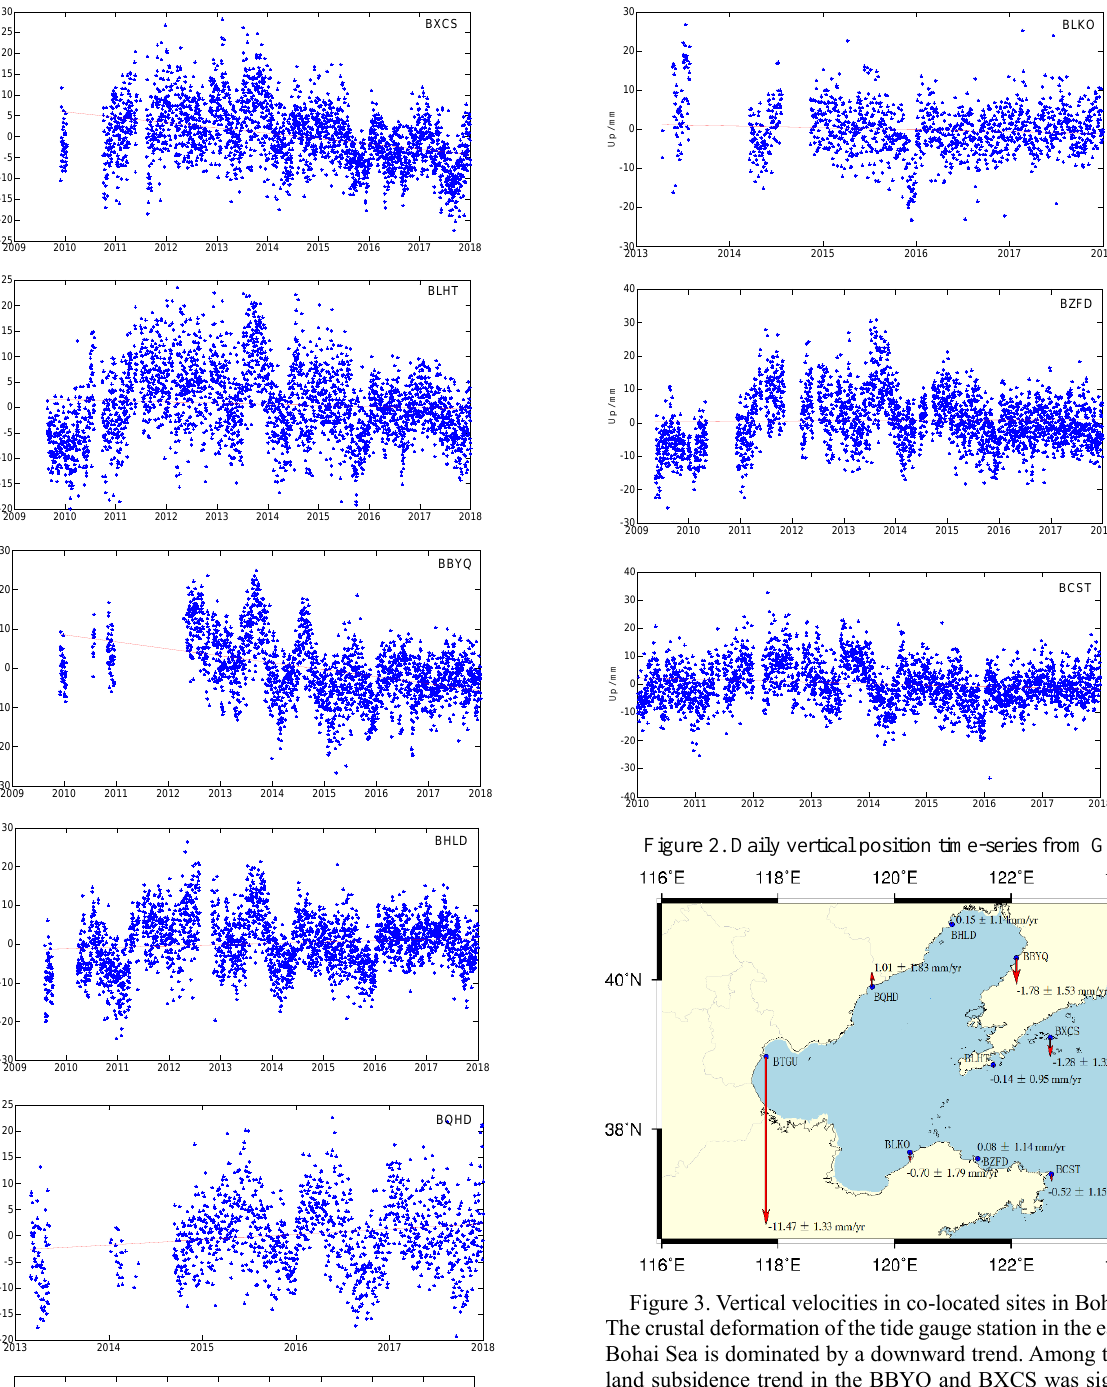
Figure 3. Vertical velocities in co-located sites in Bohai sea The crustal deformation of the tide gauge station in the east of the Bohai Sea is dominated by a downward trend. Among them, the land subsidence trend in the BBYQ and BXCS was significant, with an average annual settlement of more than 1mm. The land subsidence trend in the BLHT tide gauge is gentle, and the annual average settlement is about 0.14 mm. The vertical land motion of tide gauges in this area has a gradually decreased trend from north to south. The vertical land motion of BHLD Station is slowly increasing, with an average annual rising rate of 0.15mm/yr. The BQHD shows an upward trend of about 1.01mm/yr, which corresponds to the location of the Yanshan tectonic belt and Shanhaiguan uplift area. BTGU Station has a settlement trend of 11.47 mm/yr, which is located in the subsidence zone of North China and built in the Tianjin wharf. Field investigation and analysis suggest that the settlement rate of the station may be affected by the